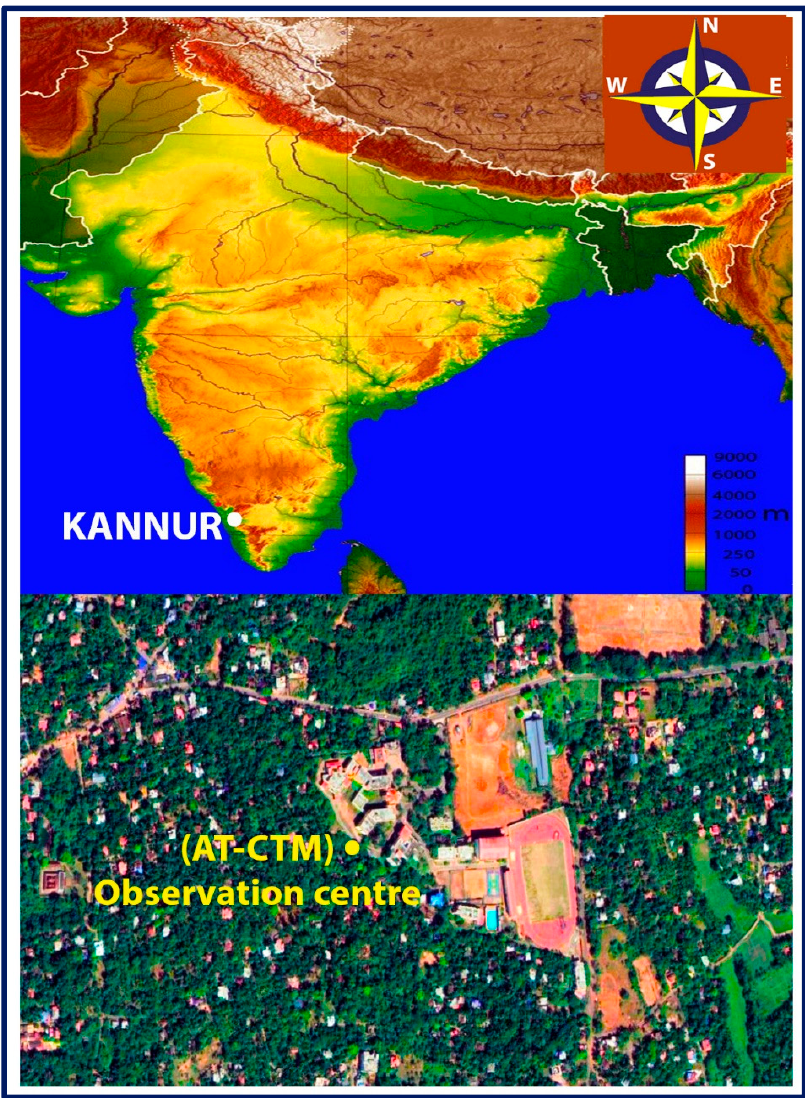
Figure 1. Geographical location of observational site at Kannur.